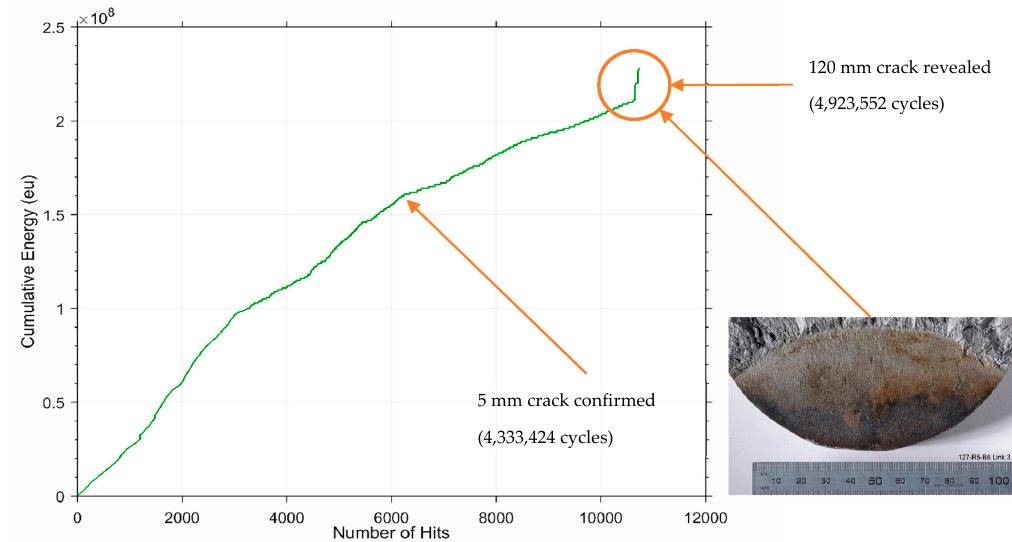
Figure 10. Cumulative energy (load > 3,820 kN) evolution as measured by the sensor fixed on Link 4. Photograph shows the fracture surface corresponding to the final crack.